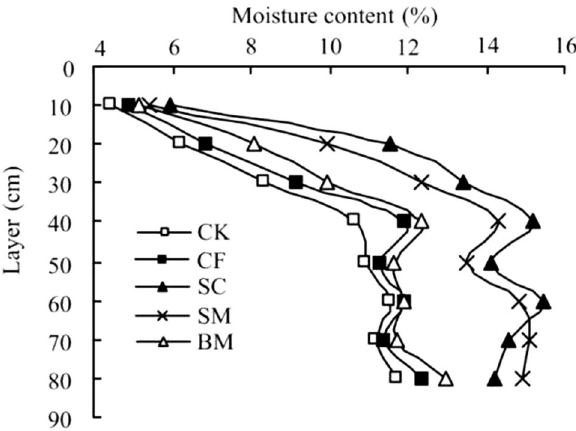
Figure 4. Effects of different fertilizer treatments on soil water content.